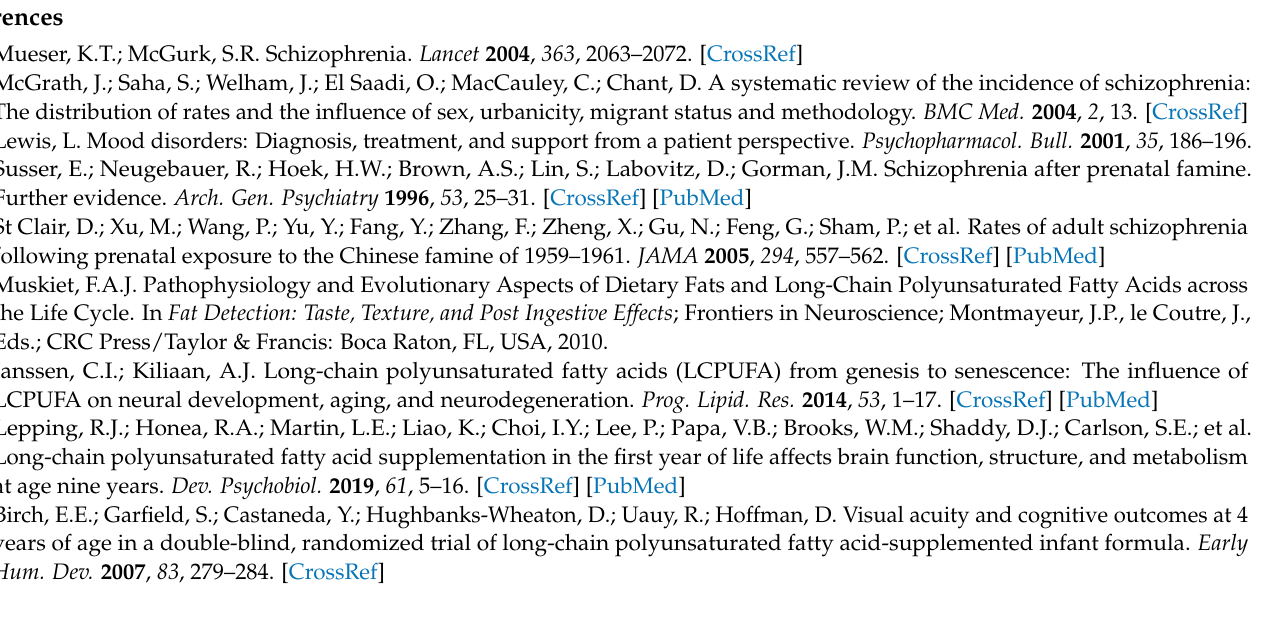
analysis GWAS; Table S3. Overall enrolled studies about incidence of schizophrenia in each country; Table S4. Enrolled studies about incidence of affective disorder and dietary PUFAs across countries; Table S5. Pleiotropy assessment of rs174547 in FDAS1 and rs16966952 in NTAN1/PDXDC1; Table S6. The instruments adjusted for the preceding fatty acid levels of three PUFAs and schizophrenia in MR analyses.; Figure S1. Results of linkage disequilibrium analysis between (A) rs174547